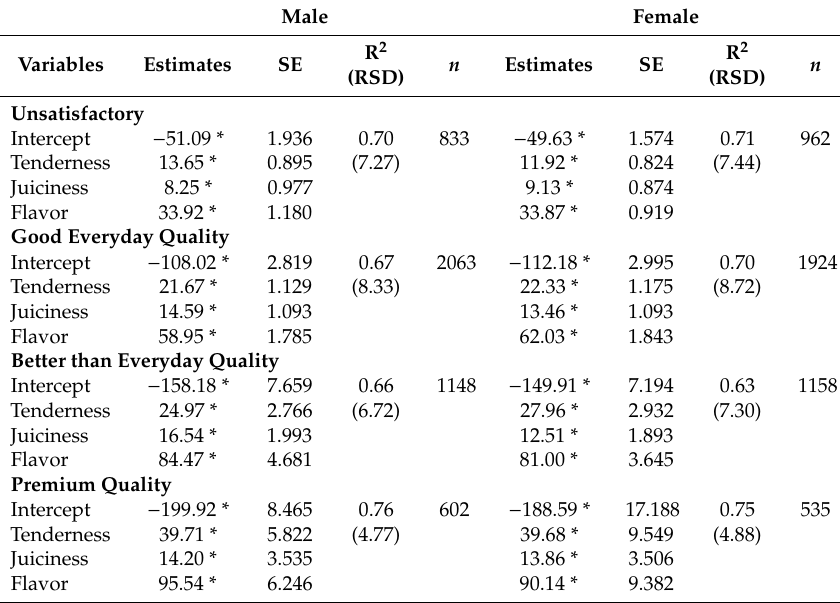
Table 8. Comparison of attribute intensity for gender by satisfaction